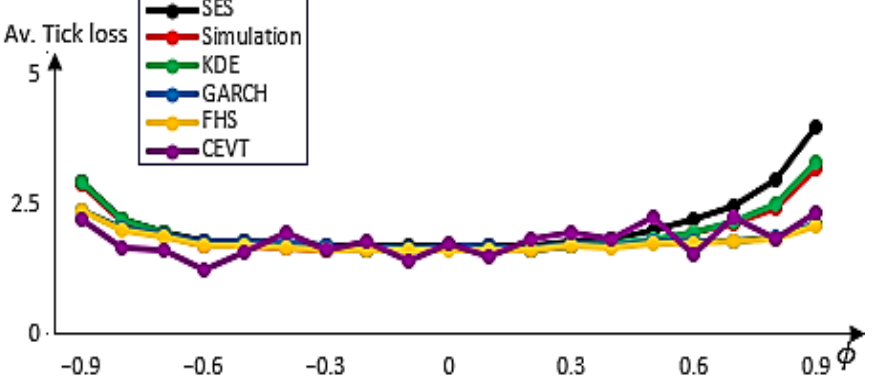
Figure 5. Average tick loss values for lead times of one week and when forecasting errors follow a gamma distribution.